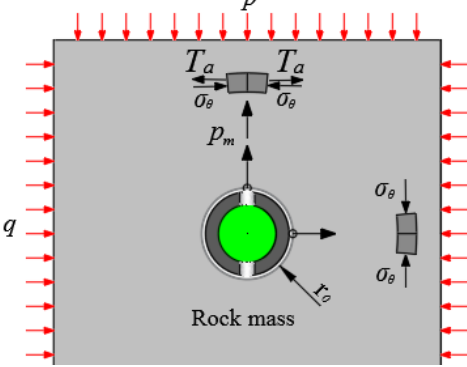
Figure 8. Diagram of initial crack propagation under confining pressure.